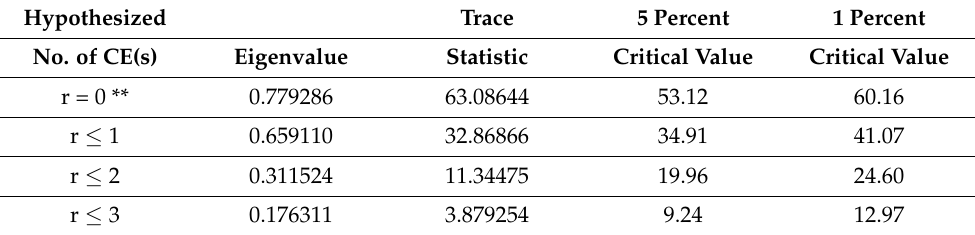
Table 4. Johansen cointegration technique results (Maximum Eigenvalue Statistics). Hypothesized Maximum Eigenvalue 5 Percent 1 Percent No. of CE(s) Eigenvalue Statistic Critical Value Critical Value r = 0 ** 0.779286 30.21778 28.14 33.24 r ≤ 1 0.659110 21.52391 22.00 26.81 r ≤ 2 0.311524 7.465498 15.67 20.20 r ≤ 3 0.176311 3.879254 9.24